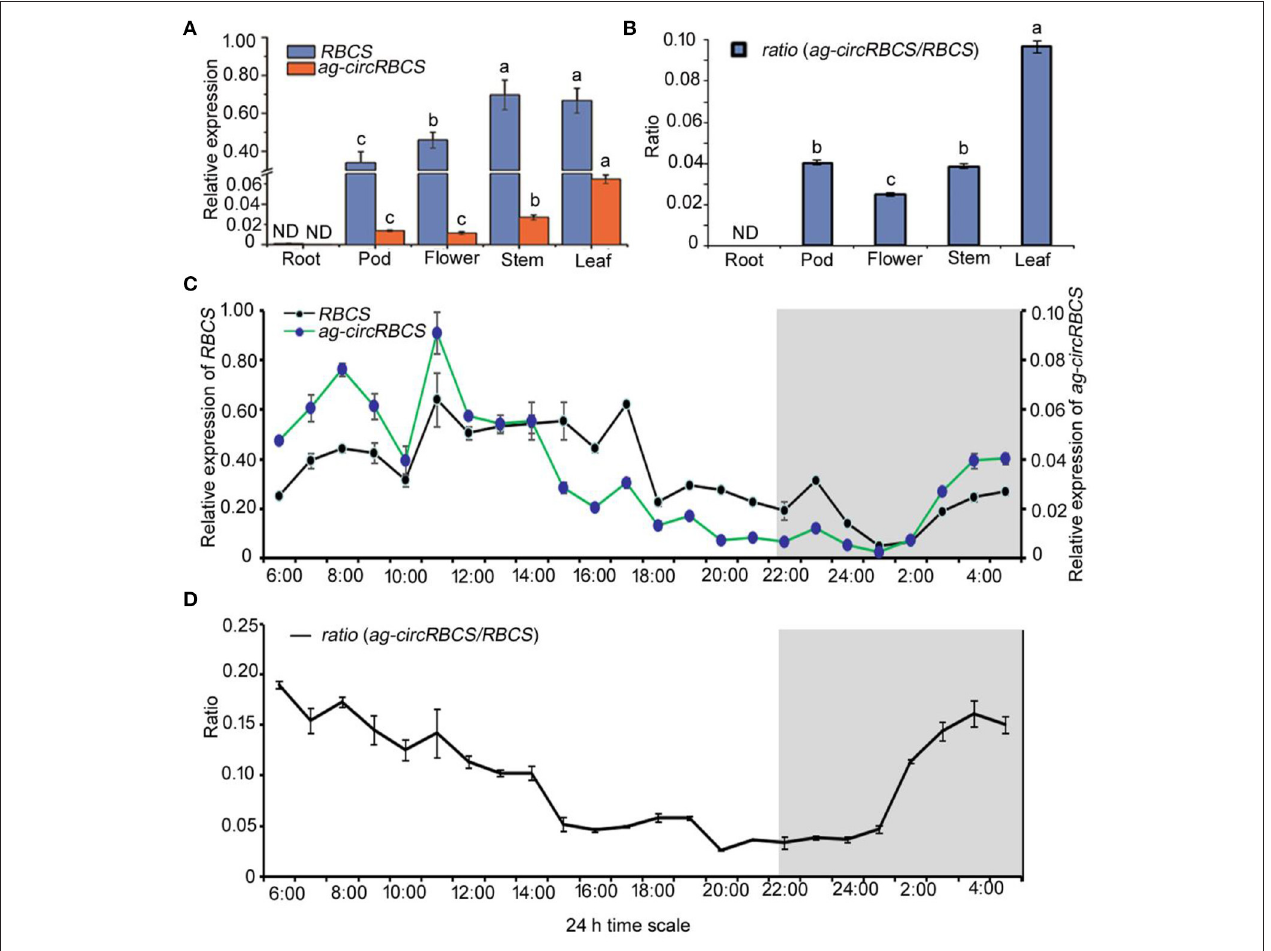
FIGURE 2 | The expression profile of RBCS and ag-circRBCS . (A) The relative expression levels of RBCS and ag-circRBCS in different tissues. (B) The expression ratio of ag-circRBCS to RBCS in different tissues. Actin was used as an internal control. (C) The expression levels of RBCS and ag-circRBCS in different time points. (D) The expression ratio of ag-circRBCS to RBCS in different time points. Actin was used as an internal control. Data are expressed as mean ± standard deviation from three independent experiments. All the data were analyzed for significant differences using ANOVA with Duncan’s test. Different lowercase letters represent statistical significances of p < 0.05 ( n = 3) of RBCS, ag-circRBCS, and ratio, respectively. ND, not